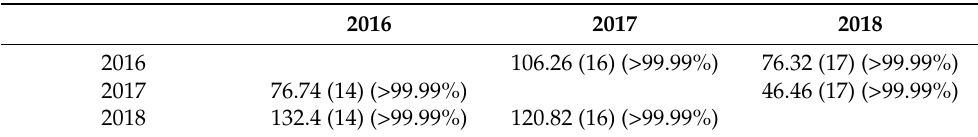
Table 2. The likelihood ratio test results of different years (in night-time conditions with street lighting